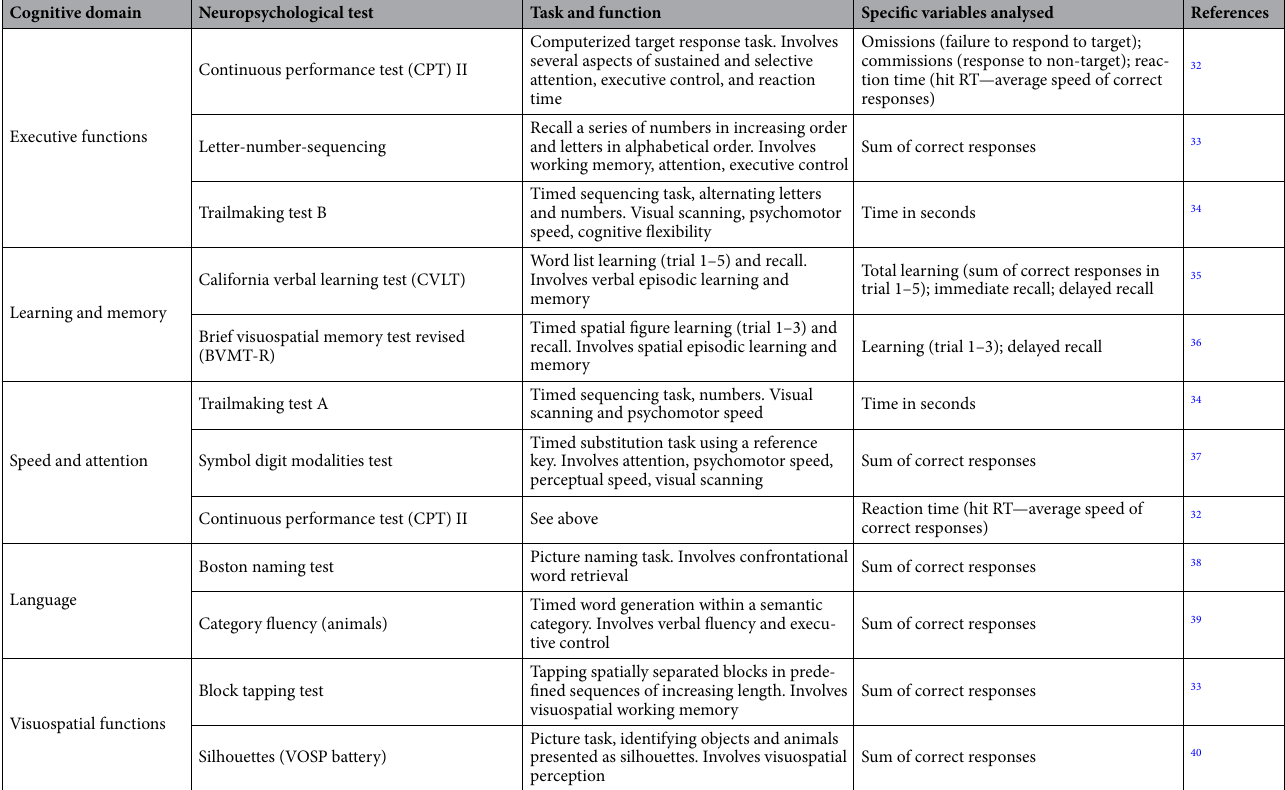
Table 2. Neuropsychological tests, domains, functions and source of normal